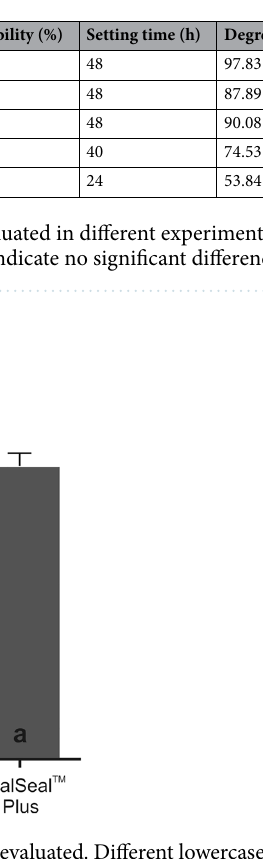
Figure 1. Radiopacity in mmAl of the endodontic sealers evaluated. Different lowercase letters indicate the presence of statistically significant differences (p < 0.05). Control group = Experimental endodontic sealer with no added vegetable extracts.